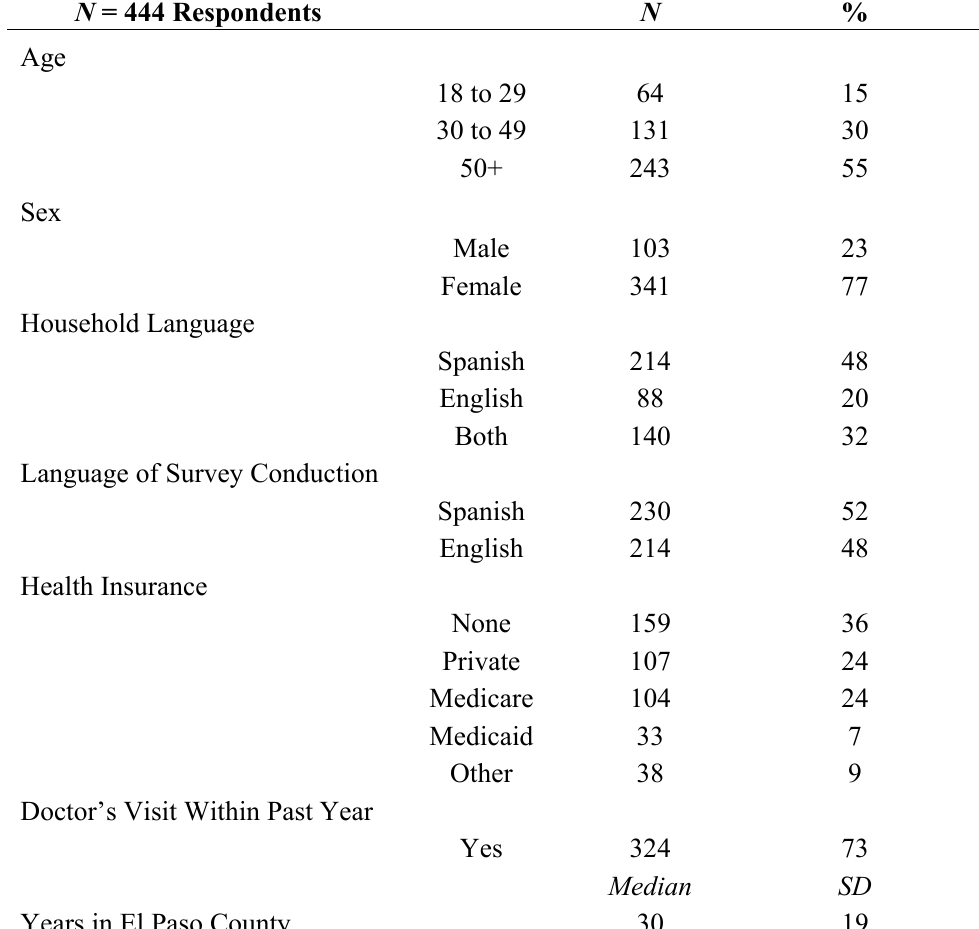
Table 1. Demographic Characteristics of Survey